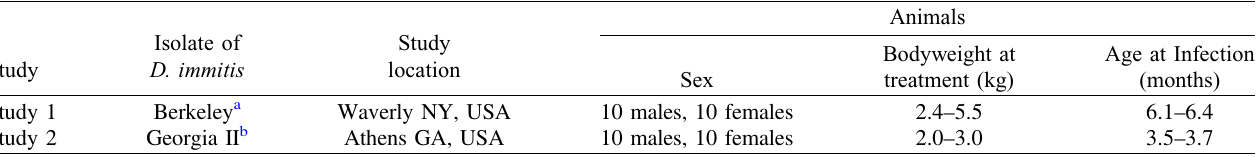
Table 1. Heartworm isolates, study locations and animal